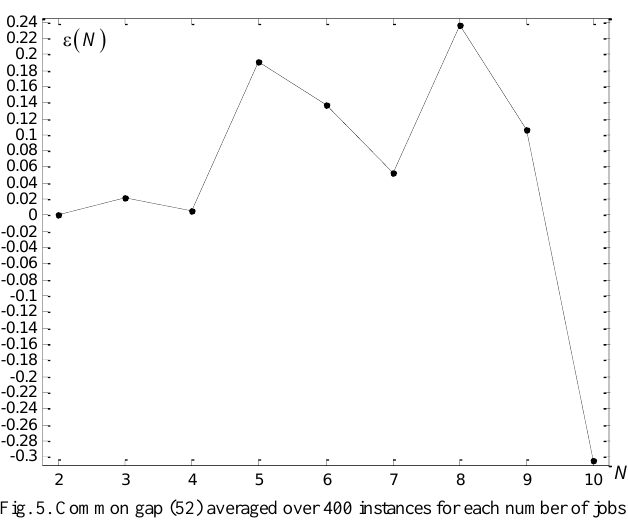
Fig. 5. Common gap (52) averaged over 400 instances for each number of jobs. It coincides with the regular gap from 2 to 7 jobs. Then, from 8 to 10 jobs, timeouts start influencing and the common gap drops similarly as in Fig.